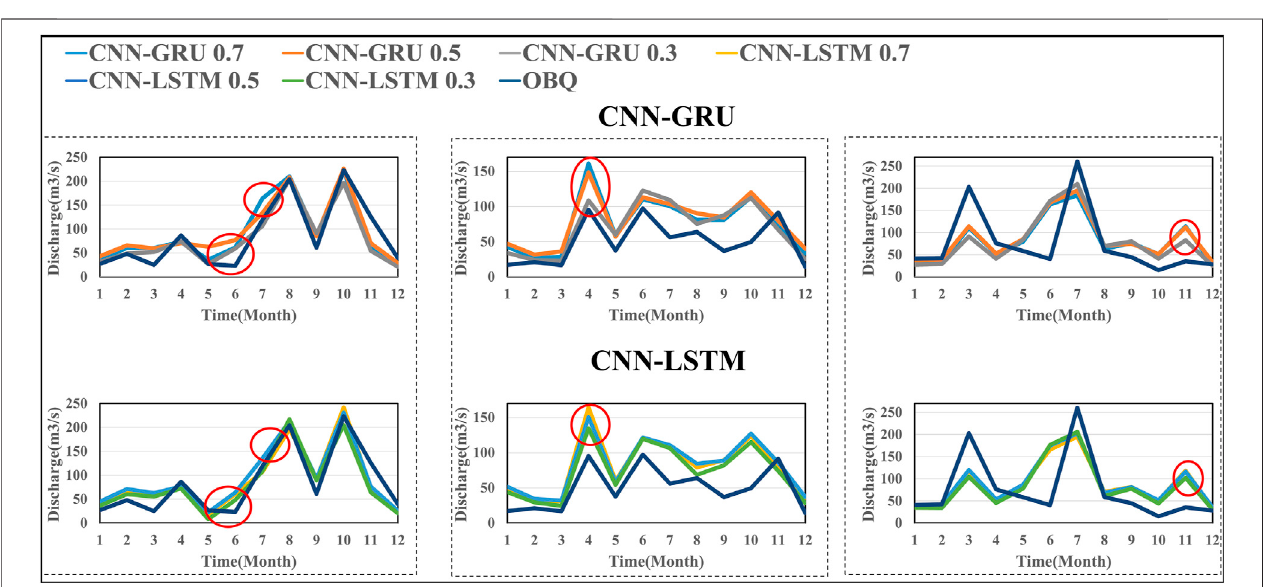
FIGURE 10 | Results of deep learning modes under different training samples (in turn: 1981, 1992, and 1997).